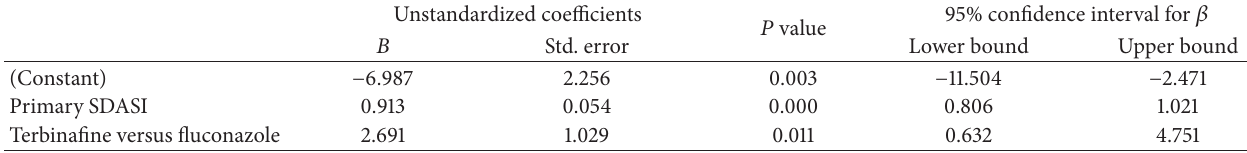
Table 3: The effects of primary SDASI and drugs on decreasing of SDASI.